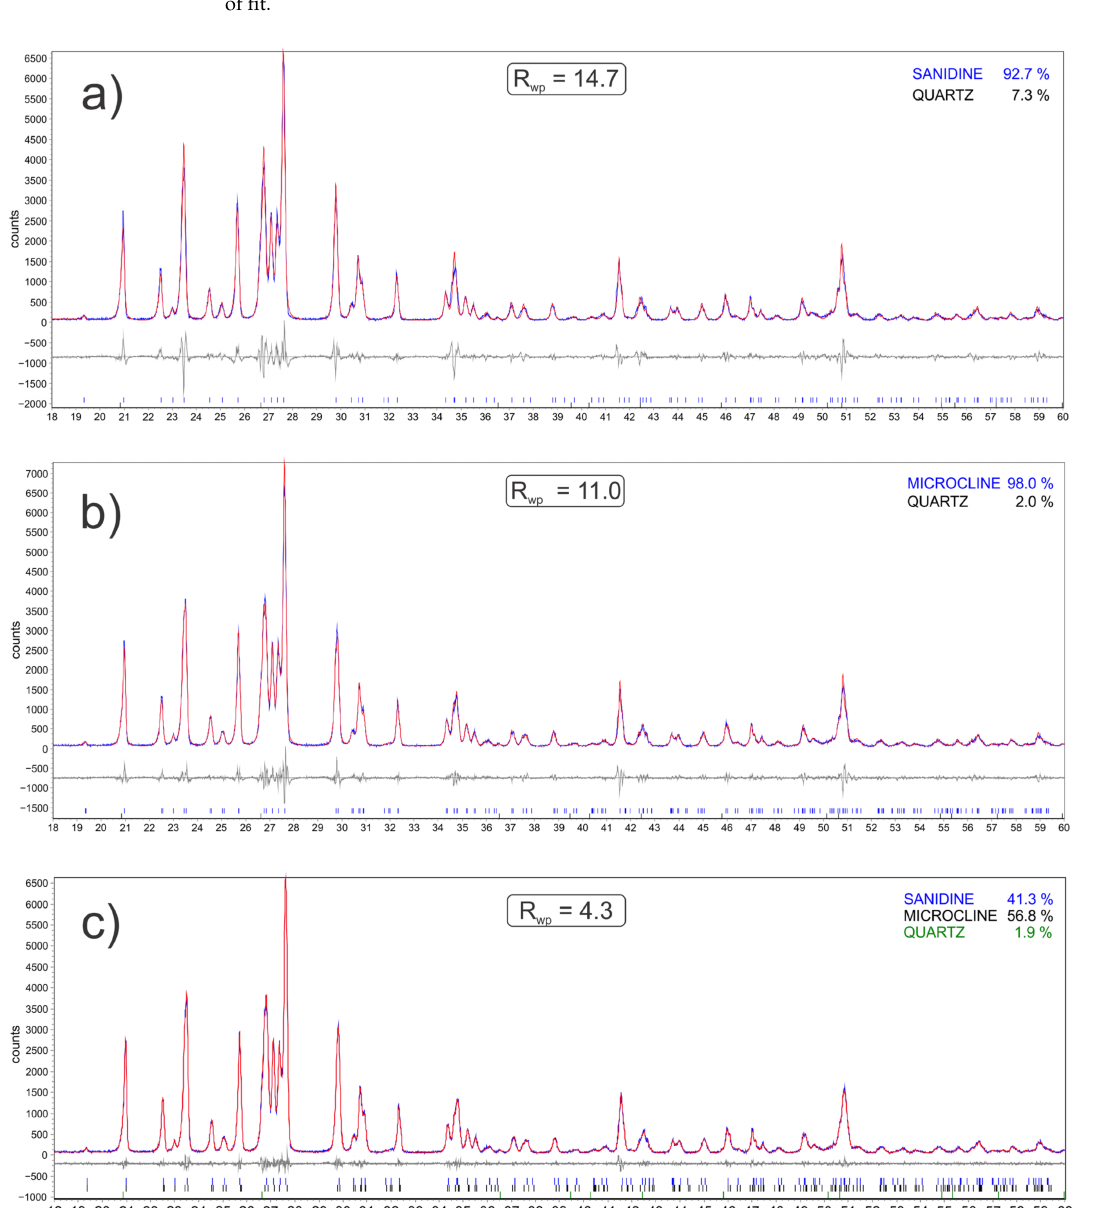
Figure 5. Rietveld refinement of adularia sample number #1 from the La Valenciana Mine, Guanajuato, Mexico. Three refinements were done to show the quality of fit using different assumptions about the crystal structure of valencianite: monoclinic plus triclinic structures (+quartz). Results reported in Table 2 are based on the ( c )